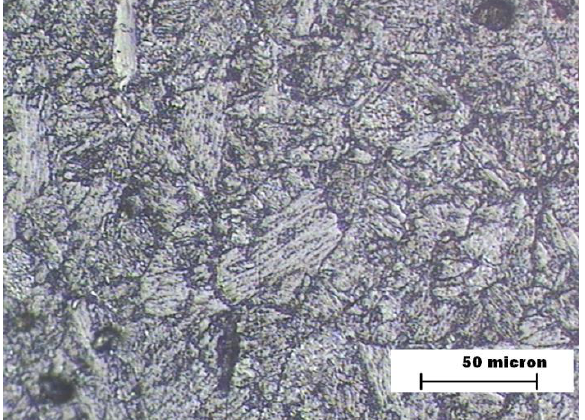
Figure 4. Sample A. Heat affected zone (HAZ) microstructure.